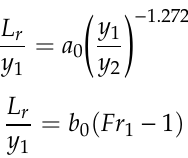
Figure 14. Comparison of the observed values of 𝐿 (cid:3045) 𝑦 (cid:2869) ⁄ with those computed by Equation (30). The roller length data obtained experimentally from this research are used to examine the applicability of Equations (26)–(28). For different expansion ratios and roughness heights, the